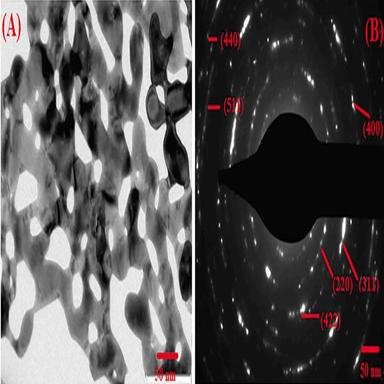
TEM micrographs of CoFe2-xSmxO4 (a) x = 0.1 and (b) SAED distribution structure of CoFe2-xSmxO4 (x = 0.1) ferrites.